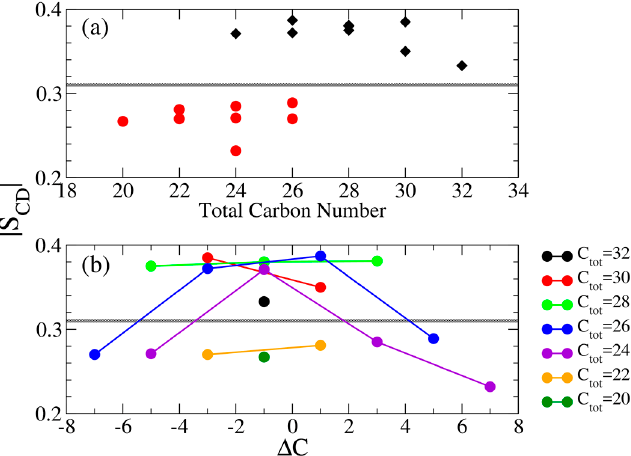
Figure 7. Averaged |S CD | value of middle segments plotted with respect to ( a ) the total alkyl carbon number (top panel) in which bilayers in S and Ld phases are colored in black diamonds and red dots, respectively, and ( b ) Δ C (bottom panel) in which each line represents systems with equal total alkyl carbon numbers. The gray lines represent the threshold value of |S CD | = 0.31 to distinguish the Ld and S phases.